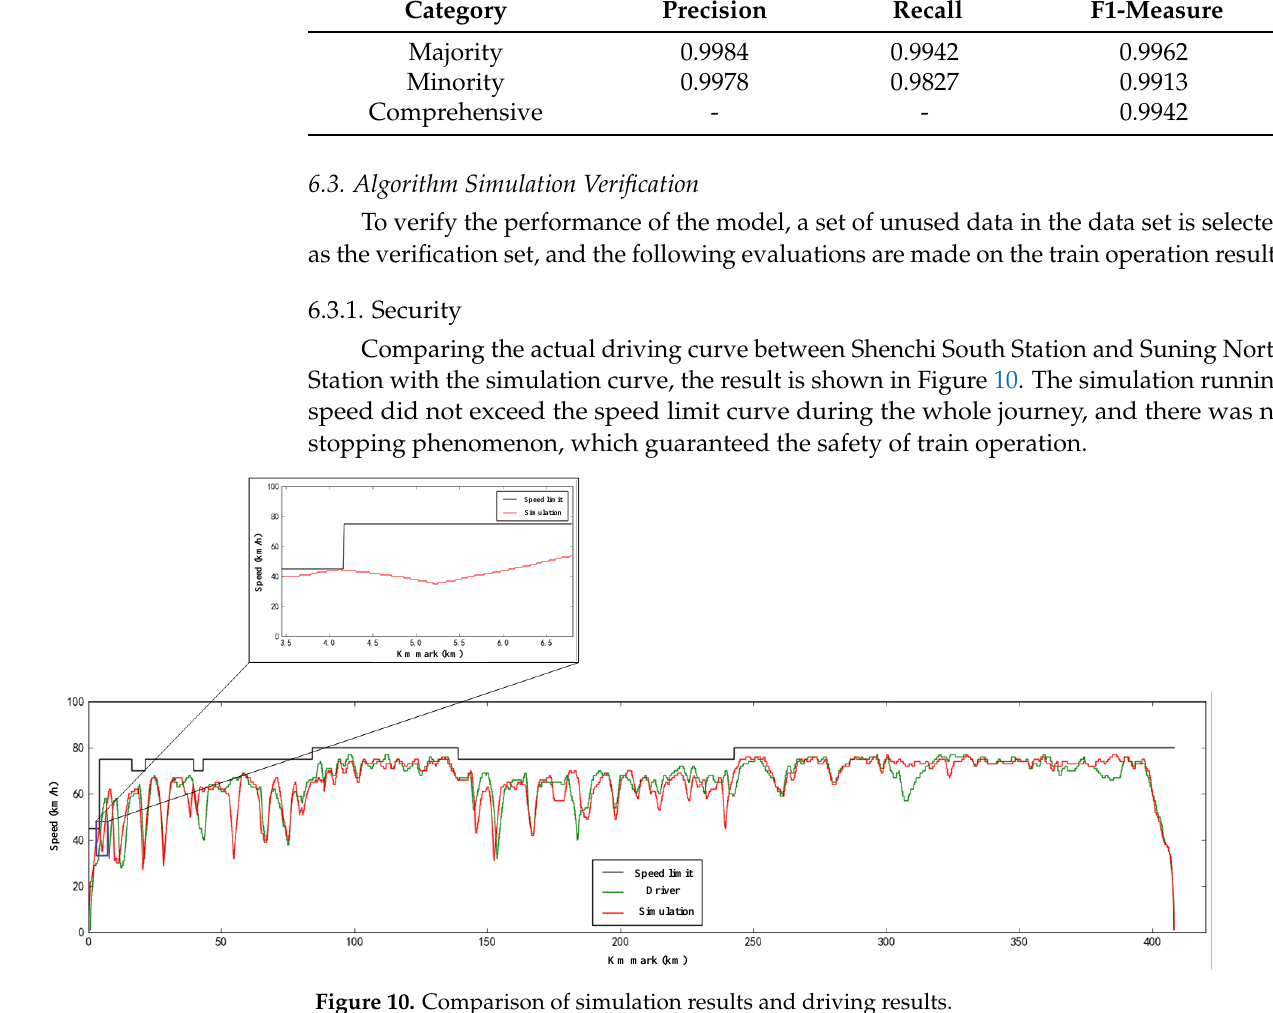
Figure 10. Comparison of simulation results and driving